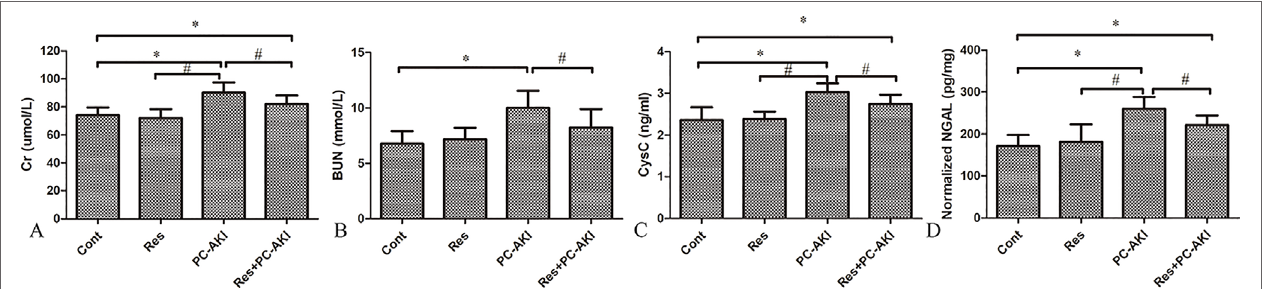
FIGURE 1 | Changes in renal function were evaluated after the injection of iohexol and co-administration of resveratrol in rabbits. Iohexol caused renal dysfunction in the PC–AKI group, while the co-administration of resveratrol decreased the level of Cr (A) , BUN (B) , CysC (C) and NGAL (D) . * P < 0.05 vs. Cont; # P < 0.05 vs. PC–AKI. Cr, serum creatinine; BUN, urea nitrogen; CysC, cystatin C; NGAL, neutrophil gelatinase–associated lipocalin; Cont, control; Res, resveratrol; PC–AKI, post-contrast acute kidney injury.